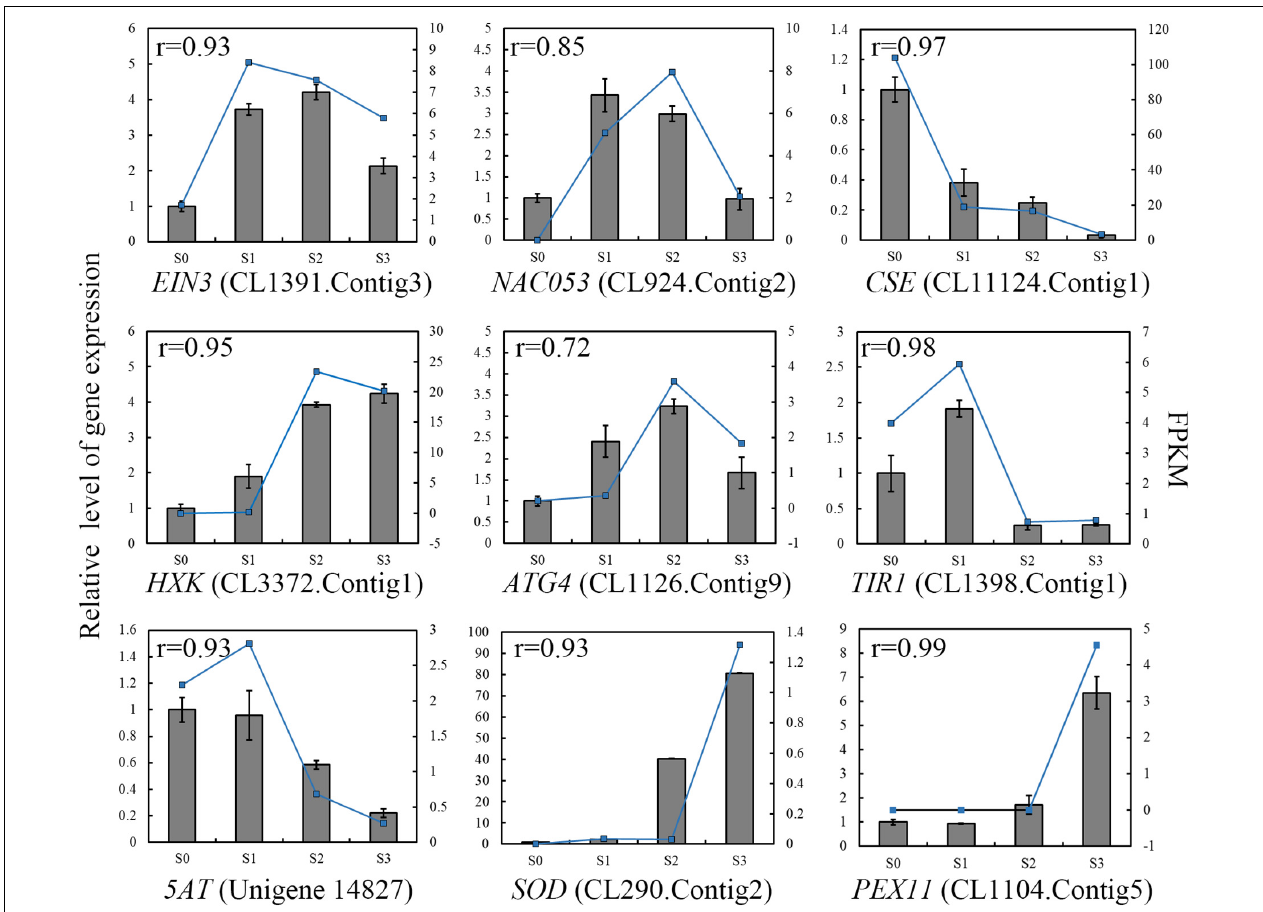
FIGURE 6 | qRT-PCR validation of the levels of selected transcripts during corolla closure. The columns represent relative gene expression levels of independent biological replicates (left y -axis) determined by real-time qRT-PCR. The blue lines represent the expression levels of the transcripts (right y -axis). The correlation coefficient shown in the top left corner was calculated using R (3.5.3). EIN3, Ethylene Insensitive 3; NAC053, Transcription factor NAC domain-containing protein 53; CSE, Caffeoyl Shikimate Esterase; HXK, Hexokinase; ATG4, Autophagy-related protein 4; TIR1, Transport Inhibitor Response 1; 5AT, anthocyanin